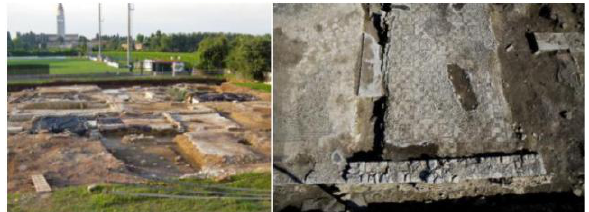
Figure 3. The Domus “dei putti